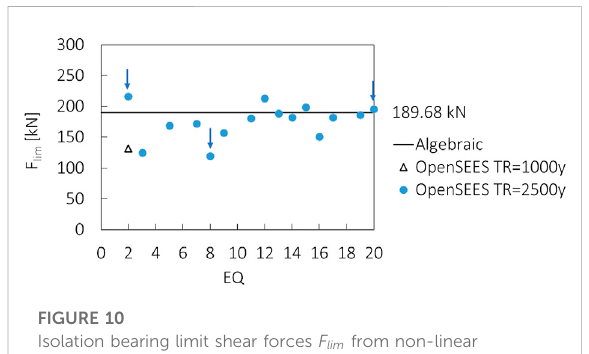
FIGURE 10 Isolation bearing limit shear forces F lim from non-linear analysis compared with the algebraic solution.